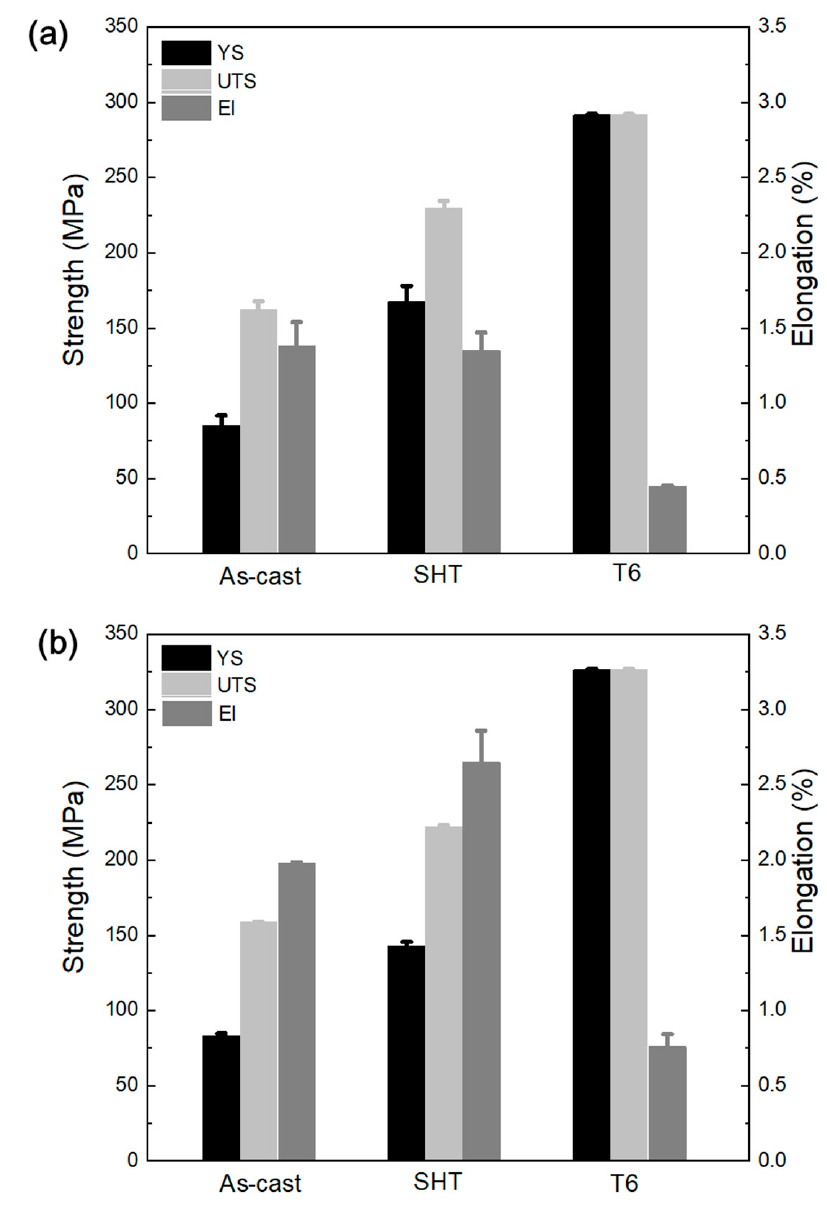
Figure 11. Tensile properties of ( a ) A1 alloy and ( b ) E1 alloy in different temper conditions. Table 3. Tensile properties of examined alloys in different Table 4. Comparison of the tensile properties of examined alloys with existing studied and com- mercial alloys.